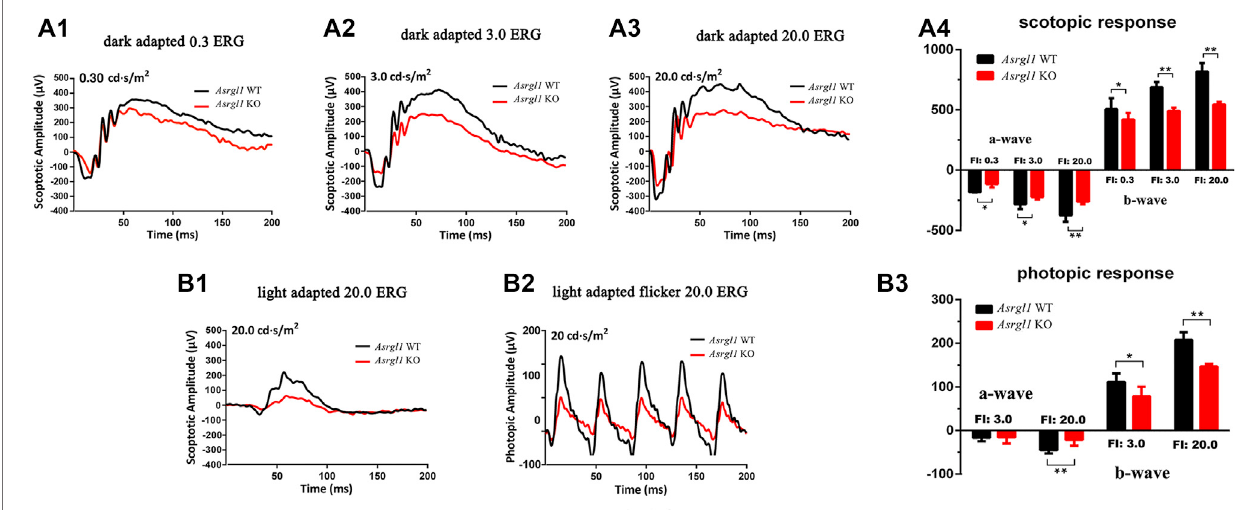
FIGURE 2 | ElectroretinogramERG) examinations of Asrgl1 KO mice. (A1 – A4) Asrgl1 KO mice at 8 months of age exhibited a reduced ERG scotopic response. Reduced amplitude peaks were observed for both the a -wave and the b -wave at light intensities of 0.3, 3.0, and 20.0 cds/m 2 in Asrgl1 KO mice; two-tailed Student ’ s t -test was used. pp p < 0.01; ppp p < 0.001. (B1 – B3) Compared with WT mice, 8-month-old KO mice exhibited a reduced photopic response at 20.0 cds/m 2 ; sample size n (cid:1) 4. A two-tailed Student ’ s t -test was used. pp p < 0.01; ppp p <